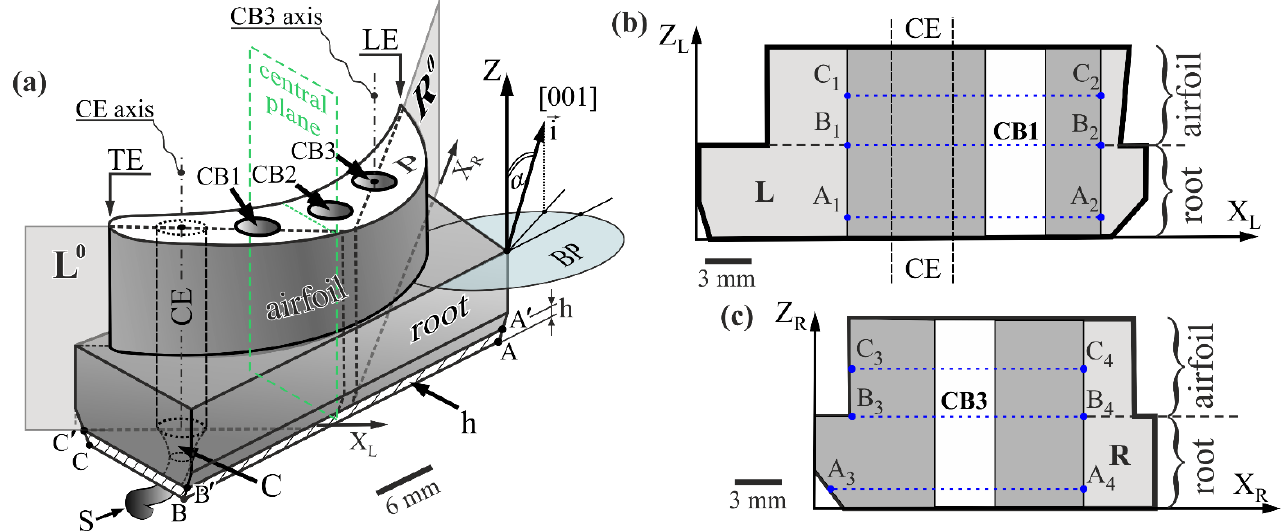
Figure 1. The scheme of the blade with the location of the cutting planes L 0 and R 0 and scheme of the graphical definition of primary crystal orientation angular component α ( a ) and shapes of the surfaces L ( b ) and R ( c ) of the sample. Z—blade axis, perpendicular to surface ABC of the root, CB1, CB2, CB3—cooling bores, S—selector, C—continuer, CE—continuer extension, h—5-mm thick bottom root layer of the unsteady dendrite growth, LE and TE—leading and trailing edge of airfoil, P—top airfoil surface, perpendicular to the Z-axis, BP—base plane parallel to ABC surface of the root and perpen- dicular to Z, 𝑖⃗ — unit vector. The α angle is enlarged for figure clarity.